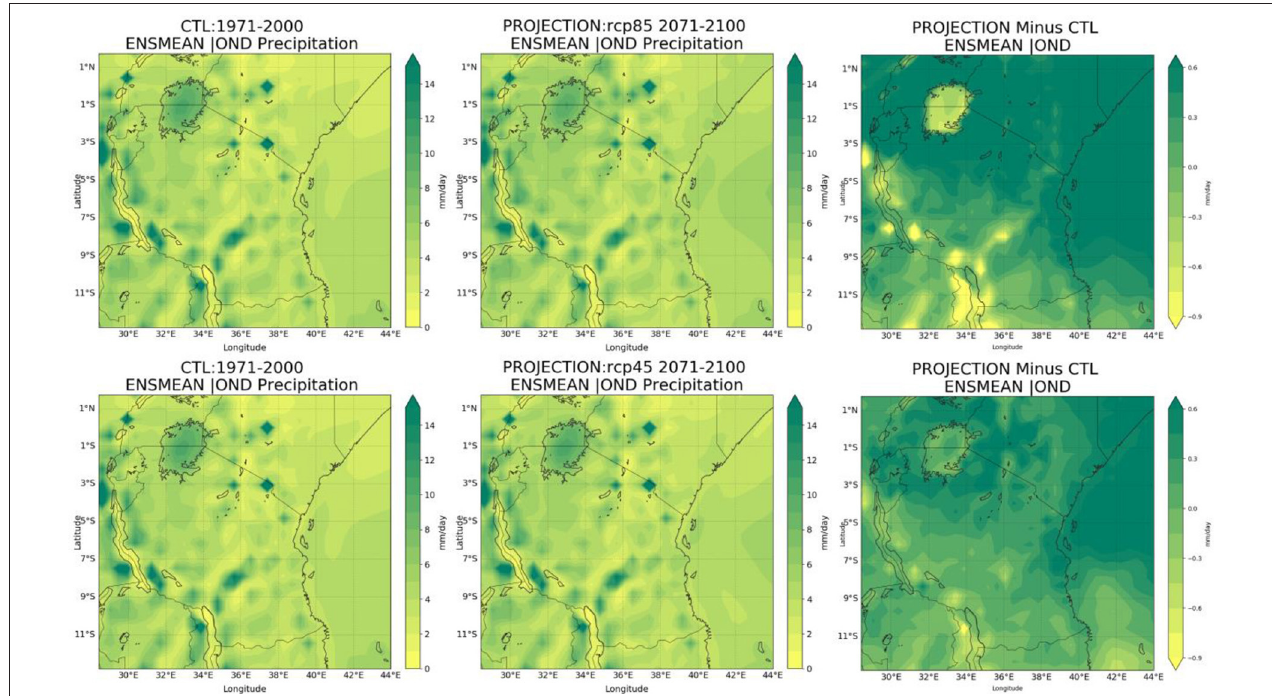
FIGURE 14 | Precipitation in mm/day for OND during base period (1971–2000), end century (2071–2100), and change in precipitation under both RCP8.5 (upper) and RCP 4.5 (lower) .